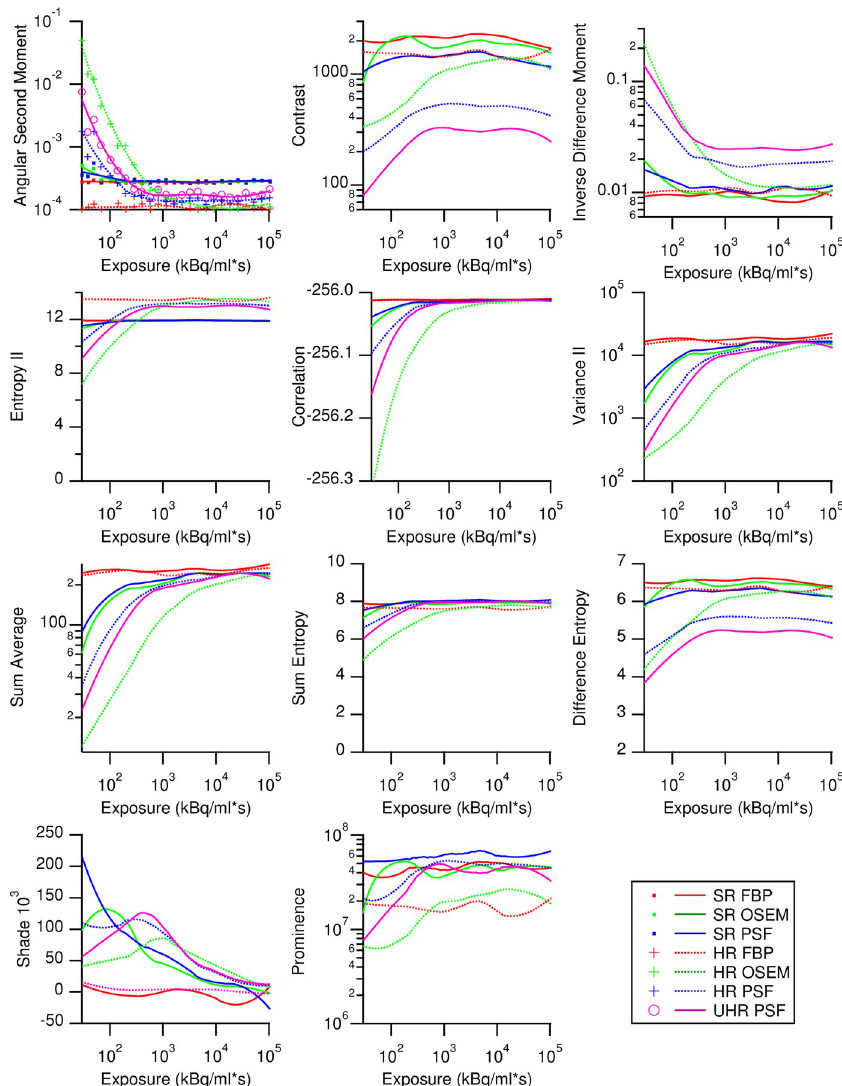
Fig 5. Exposure dependency of Haralick texture features according to different image resolution and reconstruction algorithm calculated from 8-bit GLCMs with 256 grey levels. Measurement points are shown in the first graph but omitted in the following ones for clarity, and only the interpolated Loess curves are shown. Loess confidence interval are not shown. In the ASM panel, a clinical relevant exposure range is shown in grey, taken from Krarup et al . [47]. Legend applies to